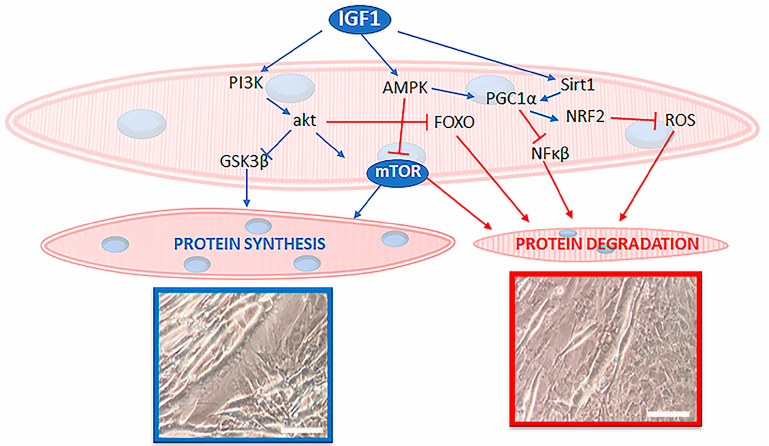
Figure 2. The scheme highlights the main anabolic actors, such as IGF-1 and mTOR, and their intra- cellular pathways in skeletal muscle biology. Signaling molecules that activate protein synthesis are colored in blue whereas those that inhibit protein synthesis and/or activate protein degradation are shown in red. Micrographs show hypertrophic (framed in blue) and atrophic (framed in red) cul- tured myotubes. Bars: 10 µm.